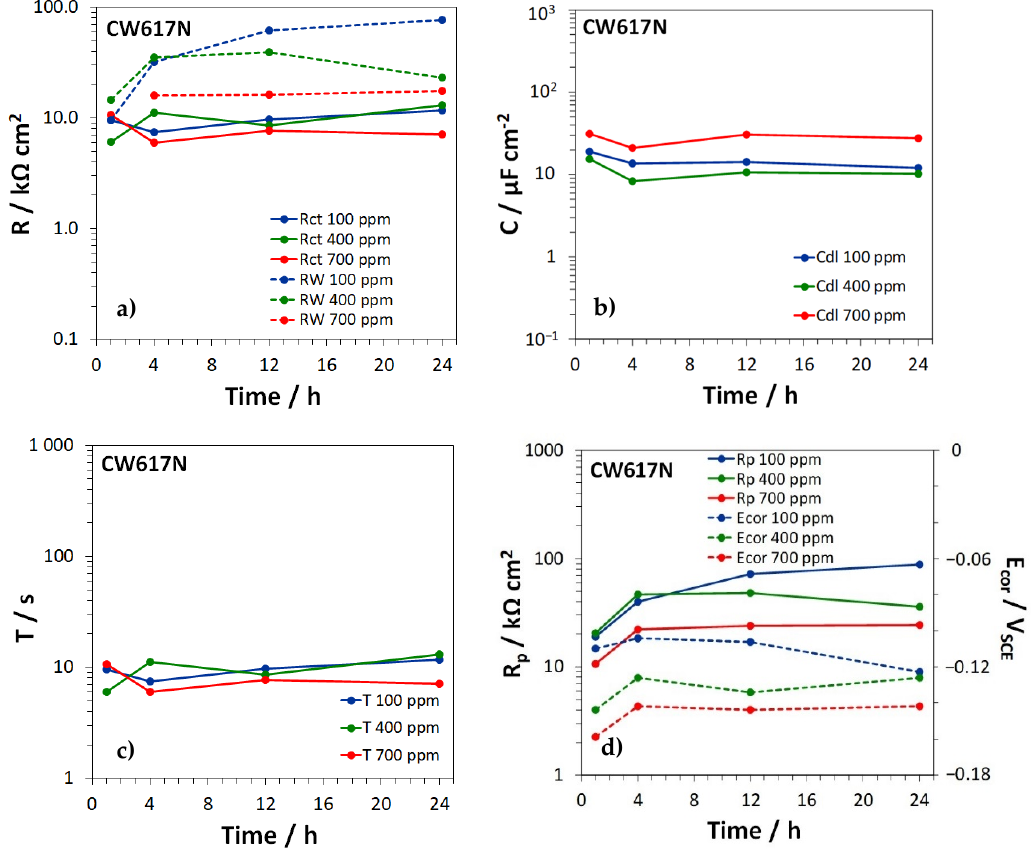
Figure 8. Time dependence of ( a ) the charge transfer and diffusion resistances ( R ct and R W ); ( b ) the double layer capacitance ( C dl ); ( c ) the T parameter of the GFLW element; and ( d ) the polarization resistance ( R p ) and corrosion potential values (E cor ), measured on CW617N during the immersion in SDW with three different chloride concentrations.